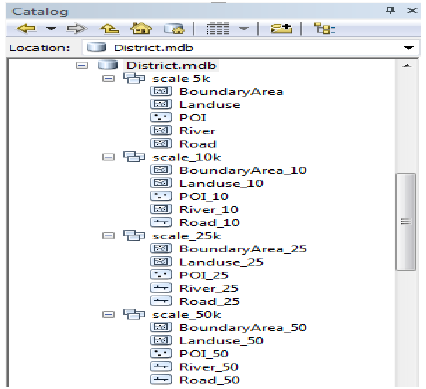
Fig. 1. A 2D redundancy problem in multi-scale approach